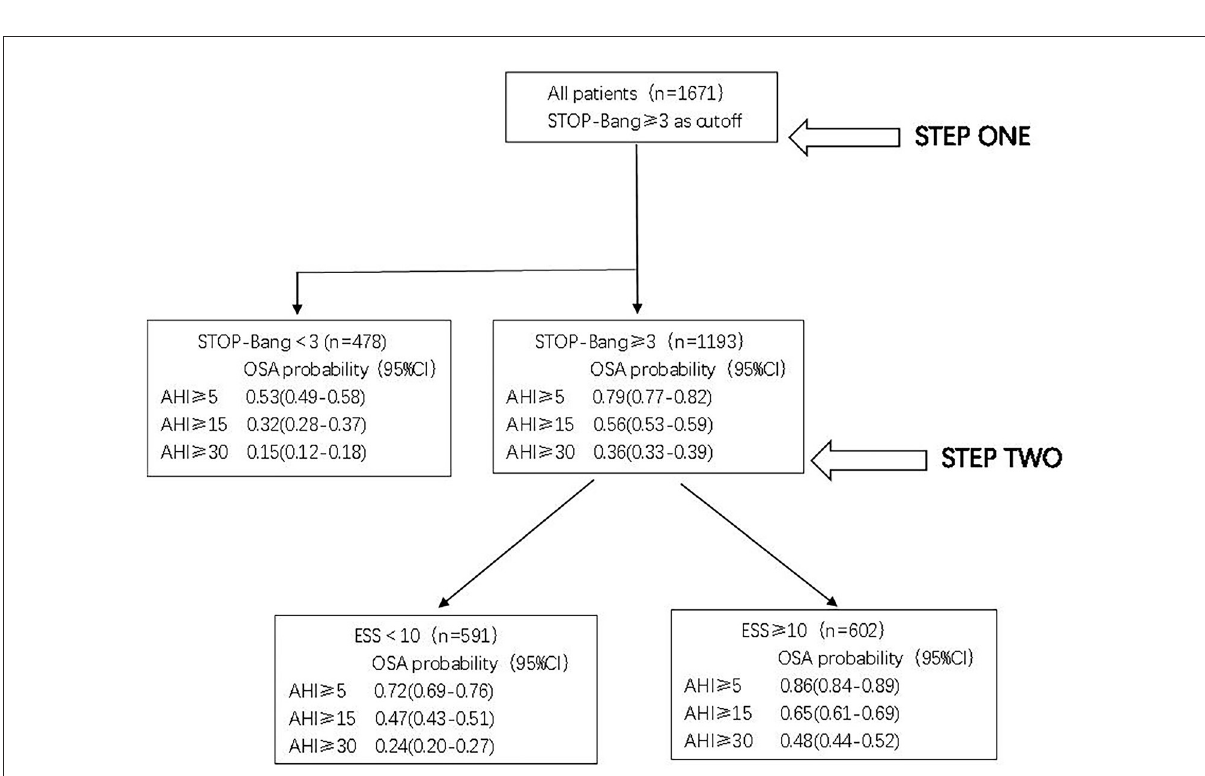
FIGURE5 Screening strategy